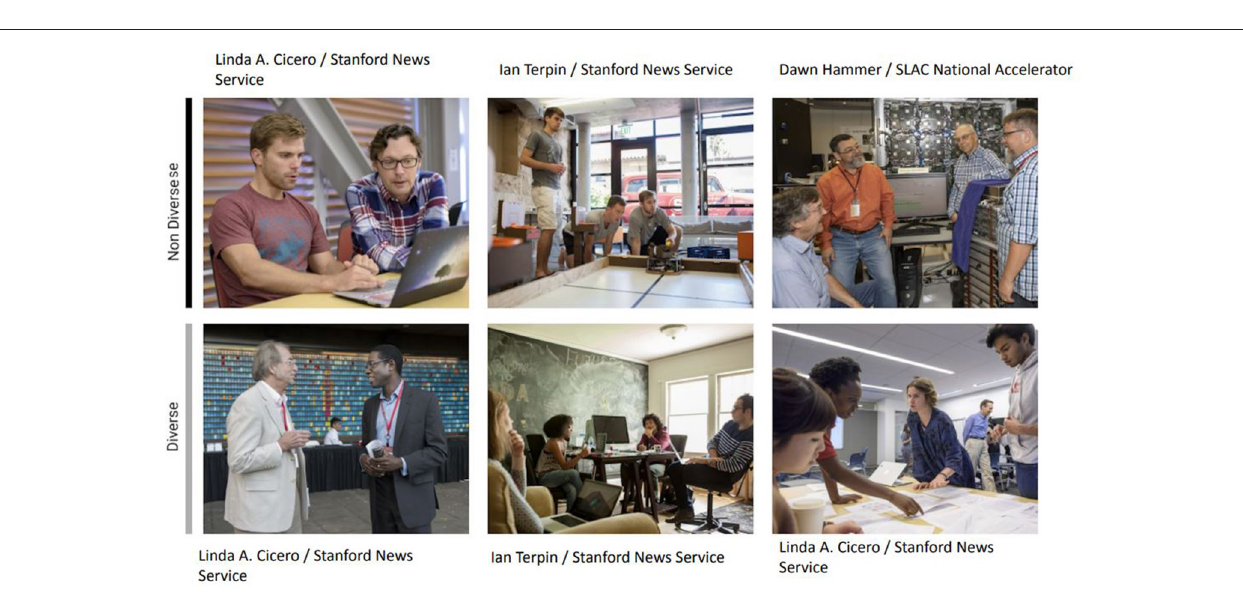
photographs. Cronbach’s alpha ranges for this survey are reported in Table 3